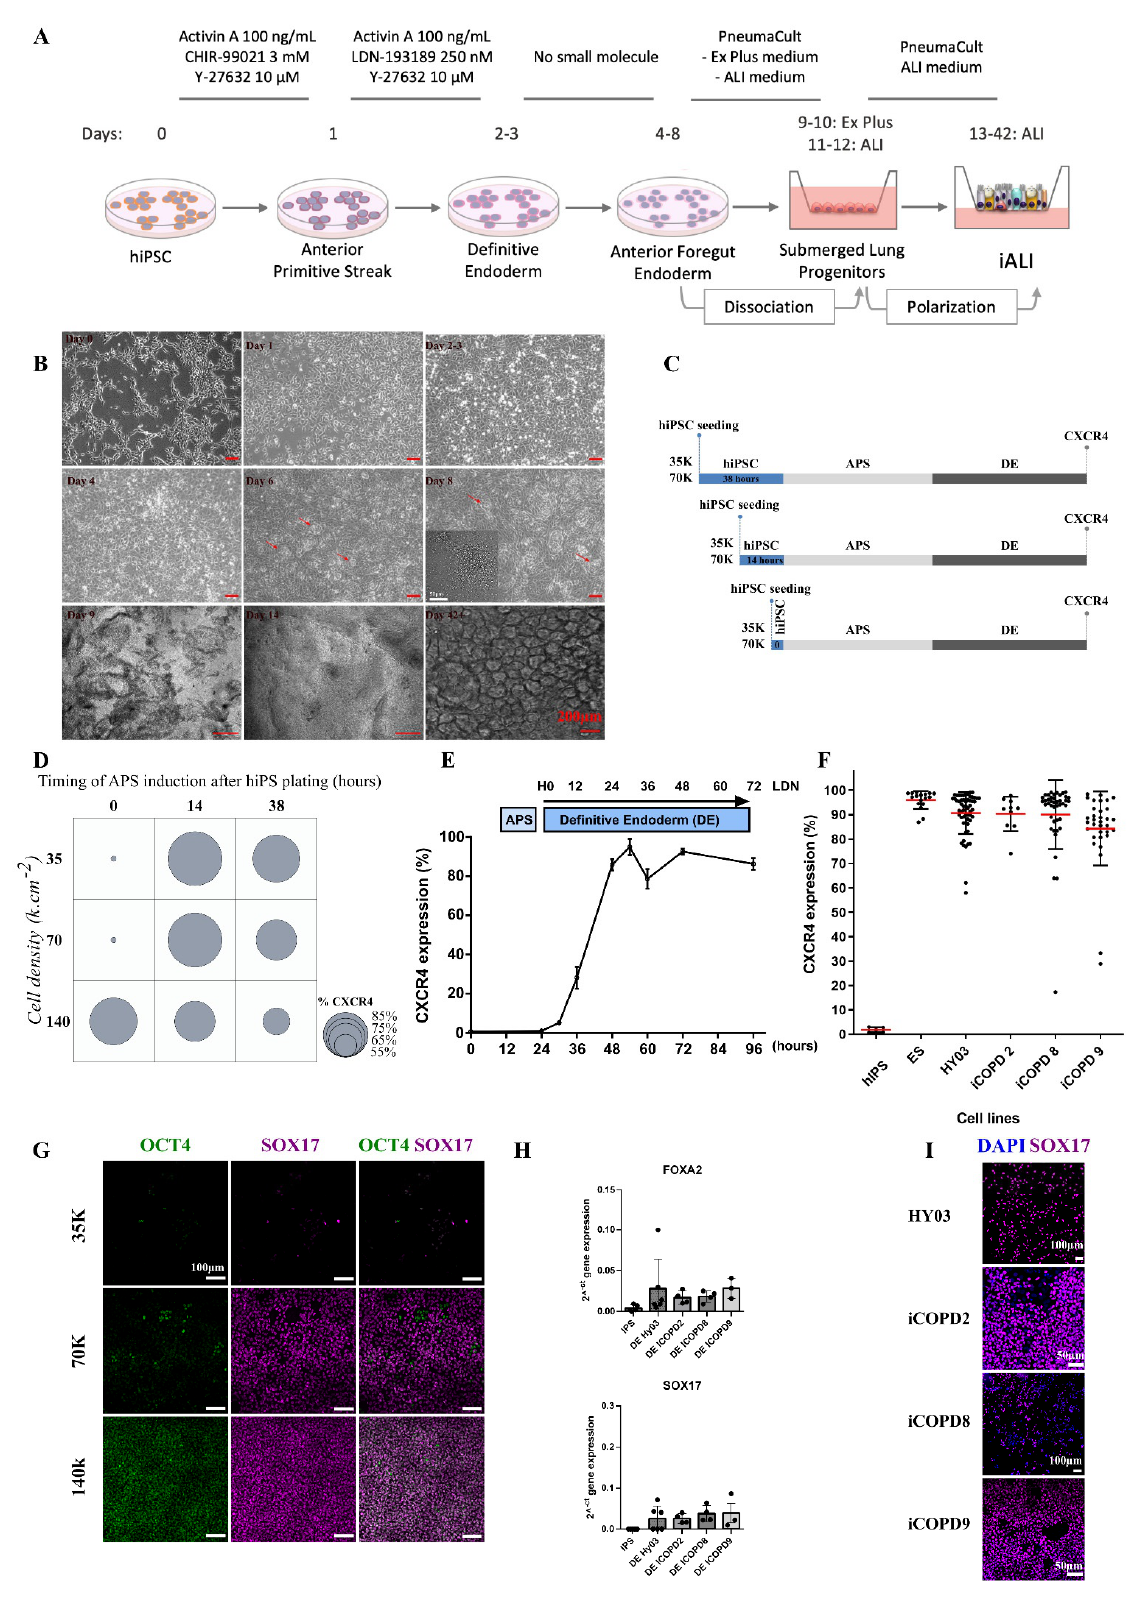
Figure 2. Differentiation of human induced pluripotent stem cells (hiPSC) into bronchial airway epithelium. ( A ) Schematic representation of the differentiation protocol. ( B ) Morphological changes during the various differentiation steps. Day 0: hiPSCs plated as single cells. Day 1: anterior